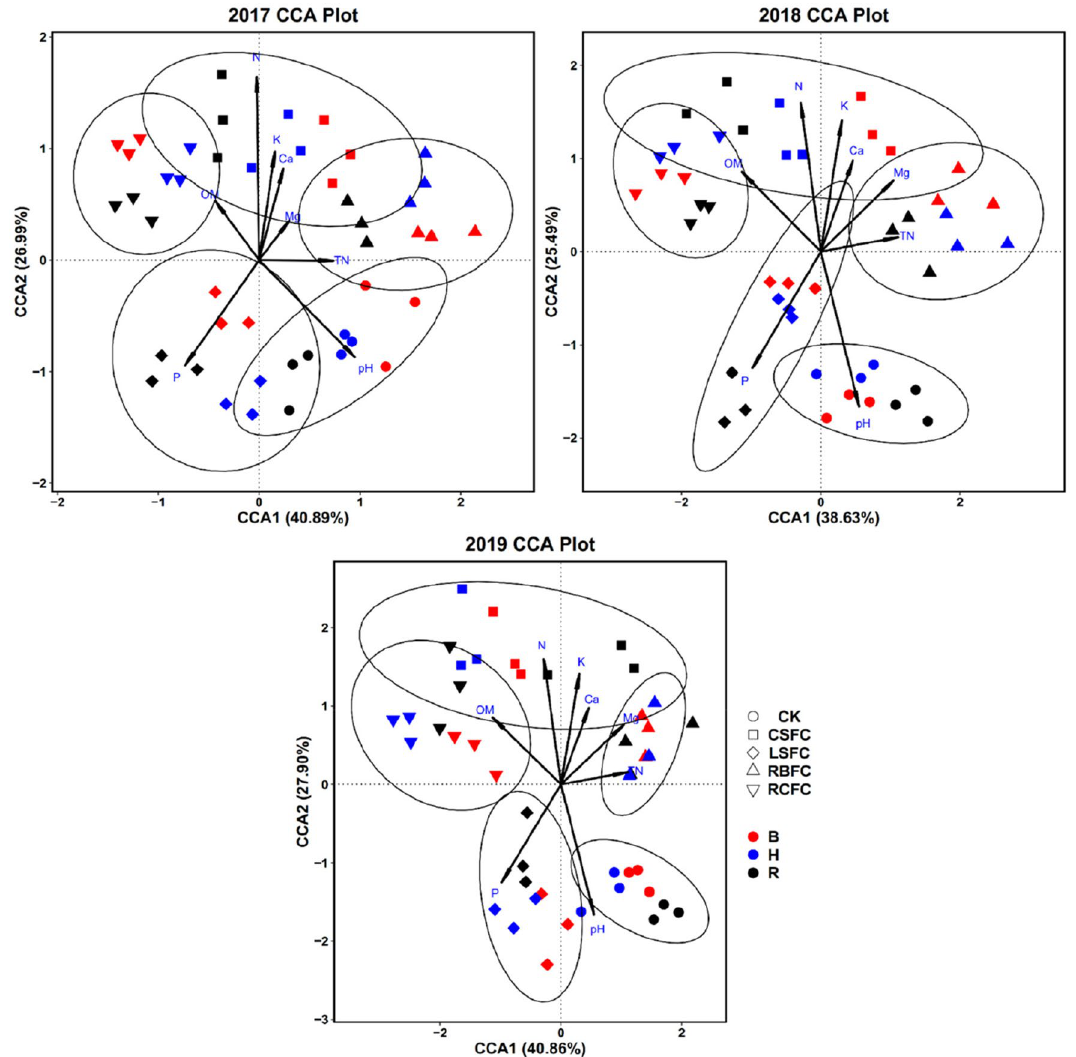
Figure 6. Canonical correspondence analysis (CCA) of the relationship between rhizospheric bacterial community and soil physicochemical properties in five treatment groups (CK, LSFC, RBFC, CSFC and RCFC) at rosette (R), budding (B) and harvesting (H) stage in 2017, 2018 and 2019. The soil properties are indicated with arrows, including soil pH, organic matter (OM), total nitrogen (TN), alkaline nitrogen (N), available phosphorous (P), available potassium (K), exchangeable calcium (Ca), exchangeable magnesium (Mg) content. The percentage of variation is explained by each